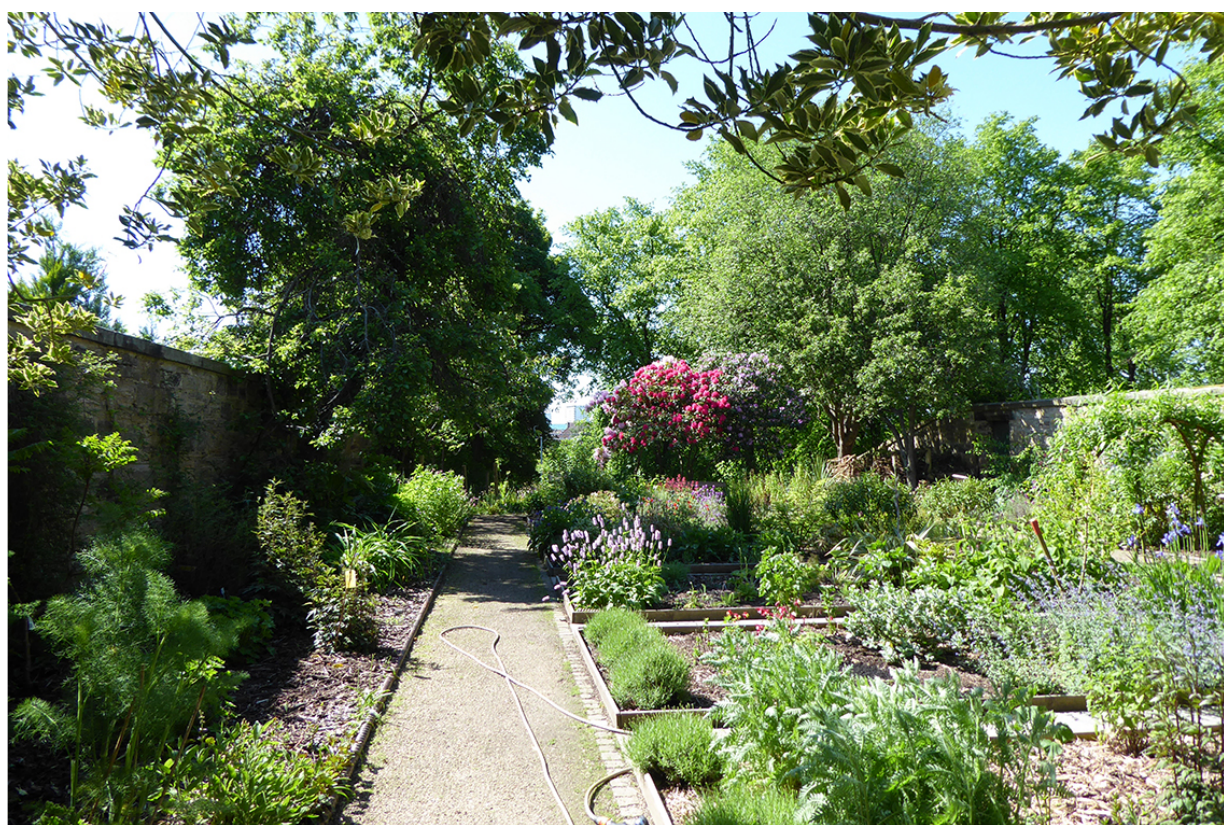
Figure 7. The walled garden at the old asylum. Source: Ebba